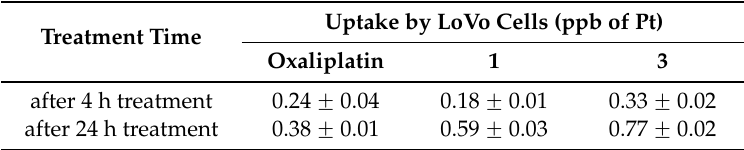
Table 4. Uptake by LoVo colon cancer cells of oxaliplatin and compounds 1 and 3